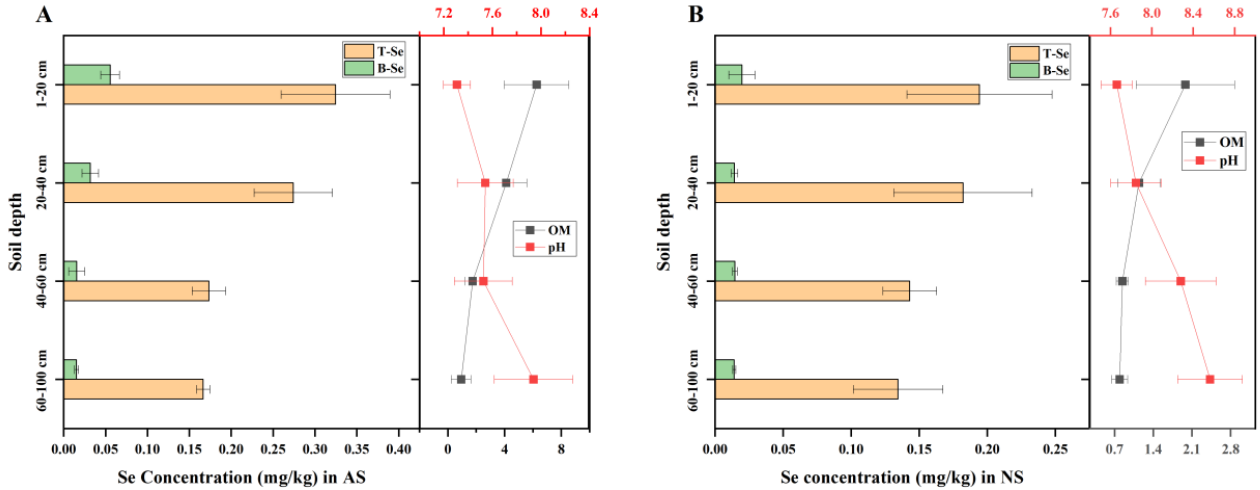
Figure 4. Soil T-Se and B-Se vertical distribution (depth 1–100 cm) in arable soil (AS) and pH and OM changes vertically in two (y)-tailed line chart ( A ), and natural soil (NS) pH and OM changes vertically in two (y)-tailed line chart ( B ).